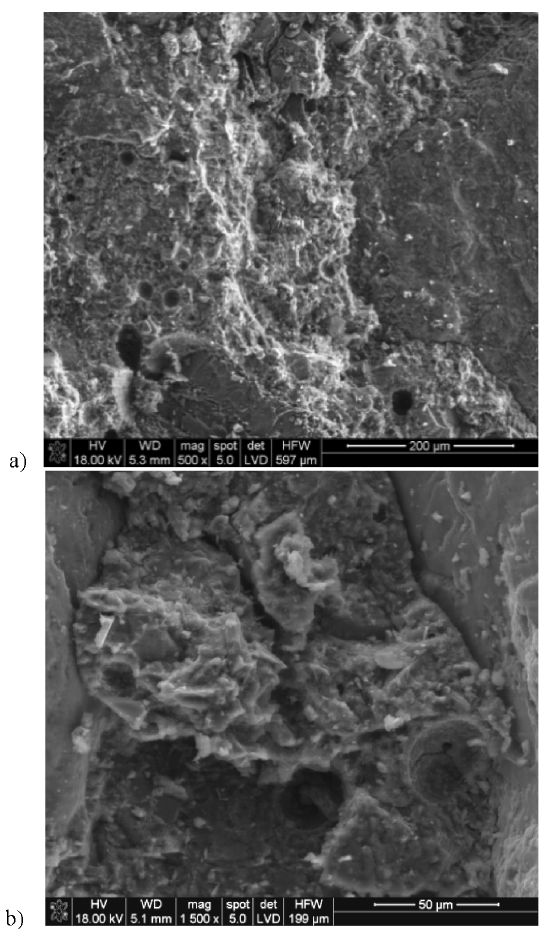
Fig. 14. SEM research results of SCC for air-entraining PCE: a) porosity; b) CSH phase